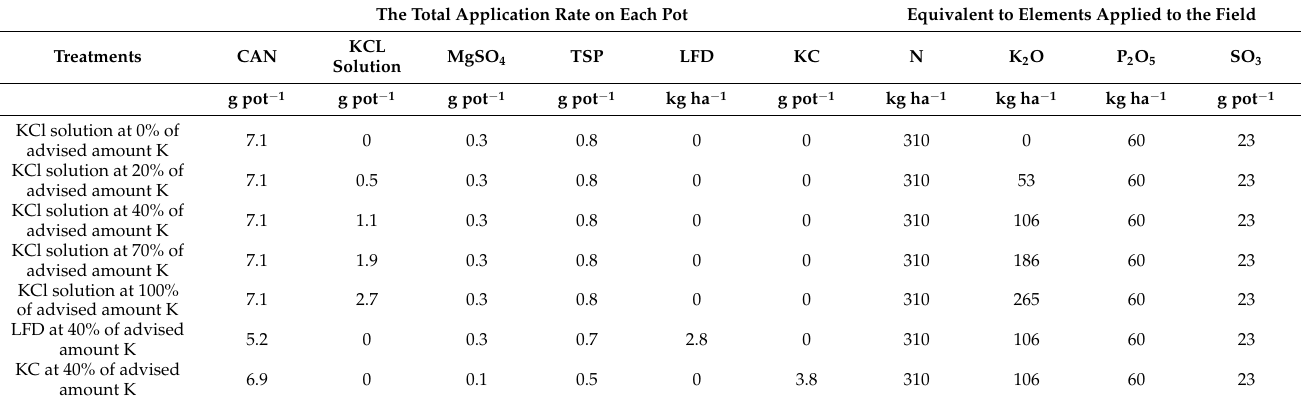
Table 4. The fertilisation scheme of the K-treatments and the equivalent amount of nutrients applied in the different treatments of the pot